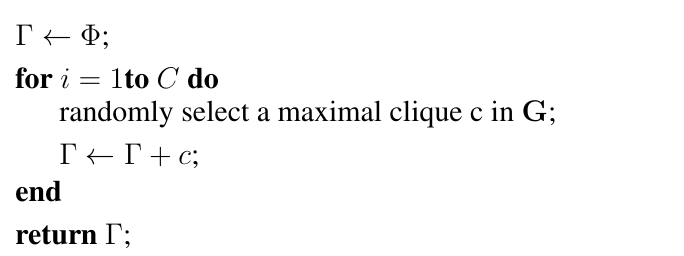
Algorithm 1 : Generate-quota